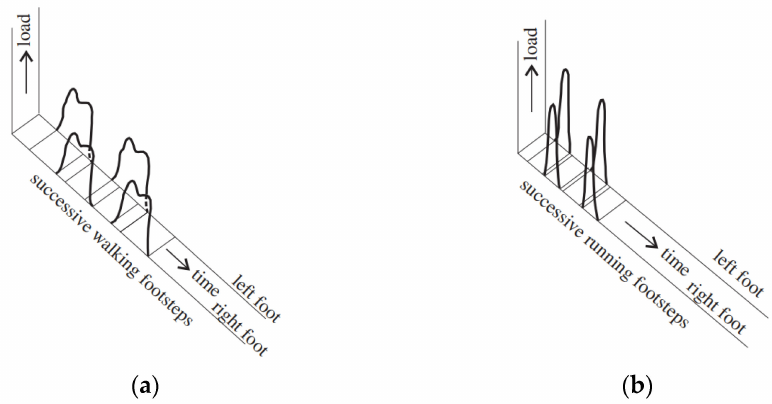
Figure 5. A 3D vertical time history of the ground force reactions (GFR) for the left and right feet during ( a ) walking and ( b ) running